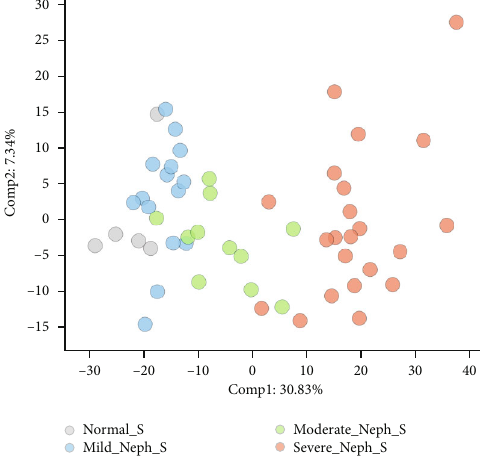
Figure 2: PCA of serum from subjects with normal kidney function (gray) and subjects with mild (blue), moderate (green), and severe (red) nephropathy.